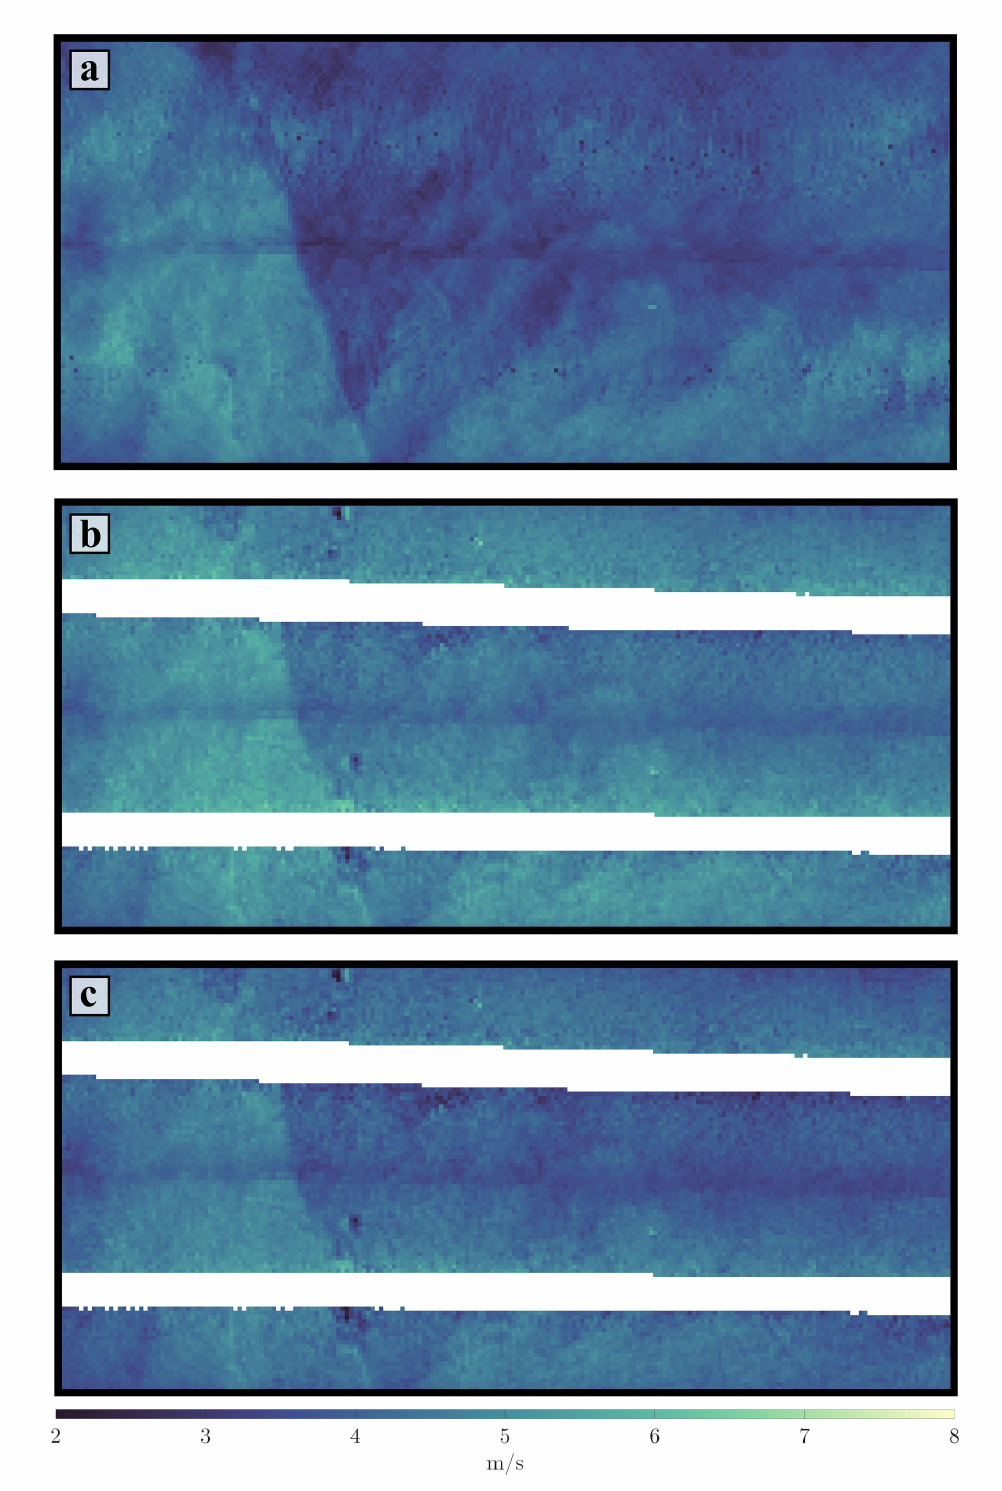
Figure 10. The DopplerScatt measured wind speed field from March 25th. ( a ) Original, scatterometer measured surface relative equivalent neutral wind field with no adjustments; same as in Figure 9, upper panel. ( b ) Vector surface currents added back into the vector surface relative equivalent neutral wind field using DopplerScatt-measured currents results in the neutral wind field. ( c ) Atmospheric stratification adjustments made in addition to surface current adjustments reveal the true wind speed at 10